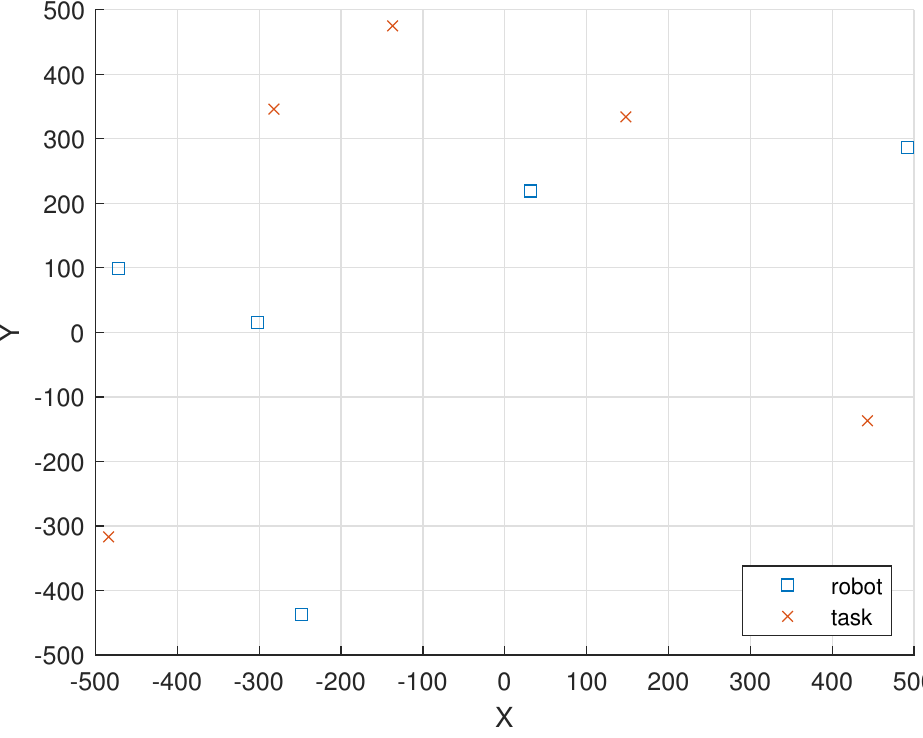
Figure 2. The locations of the 5 i.i.d. EH robot nodes and the locations of the five tasks are represented as “square” and “cross” markers, respectively.